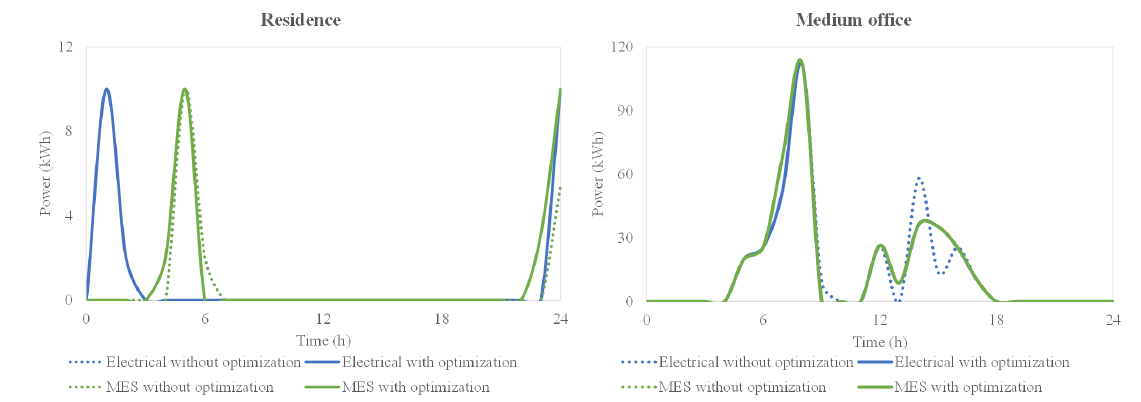
Figure 18. Electrical vehicles (EVs) charging power in a medium size office.